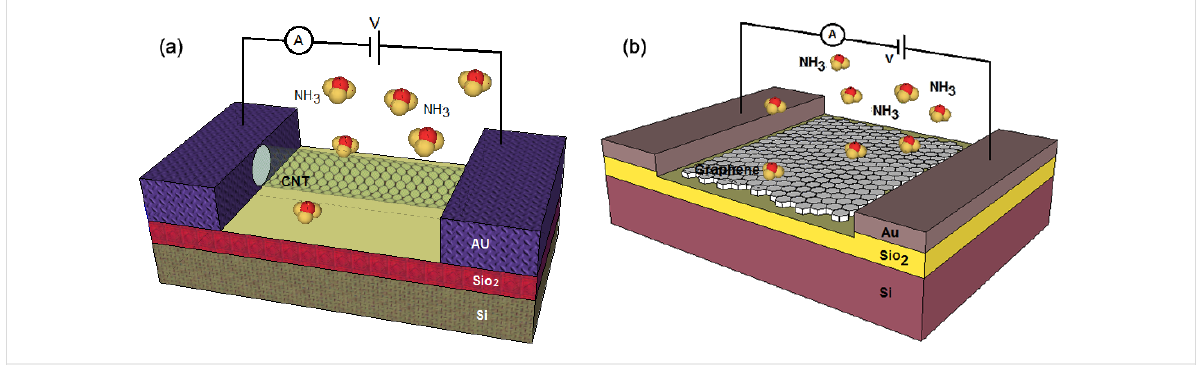
Figure 2: FET-based structure for gas sensor with (a) CNT channel and (b) graphene channel.